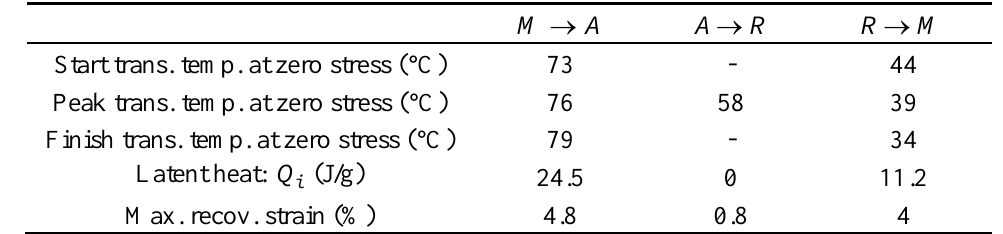
Table 2. DSC parameters of SMA